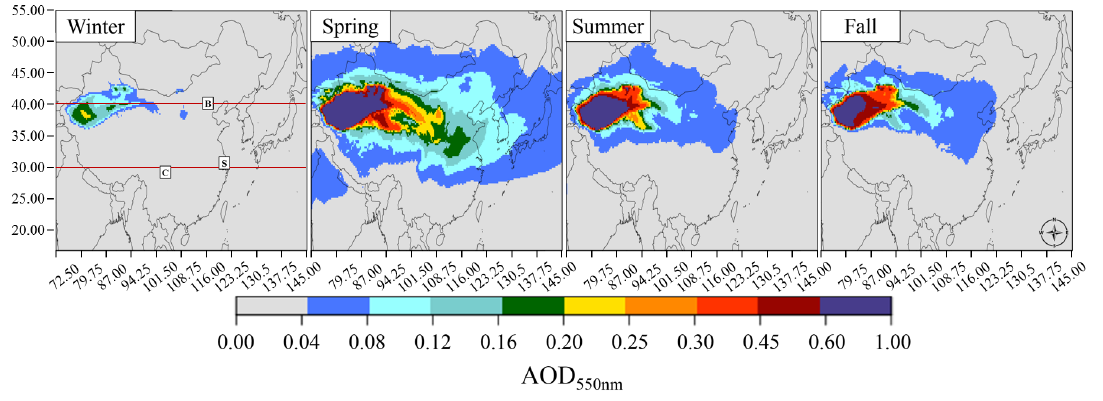
Figure 2. CHIMERE seasonal 550nm Aerosol Optical Depth (AOD) associated to dust aerosols for Winter, Spring, Summer and Fall. Beijing (B), Chengdu (C) and Shanghai (S) locations are indicated on Winter map. Red lines on Winter map indicate 39.5 ◦ and 31.0 ◦ latitudes.